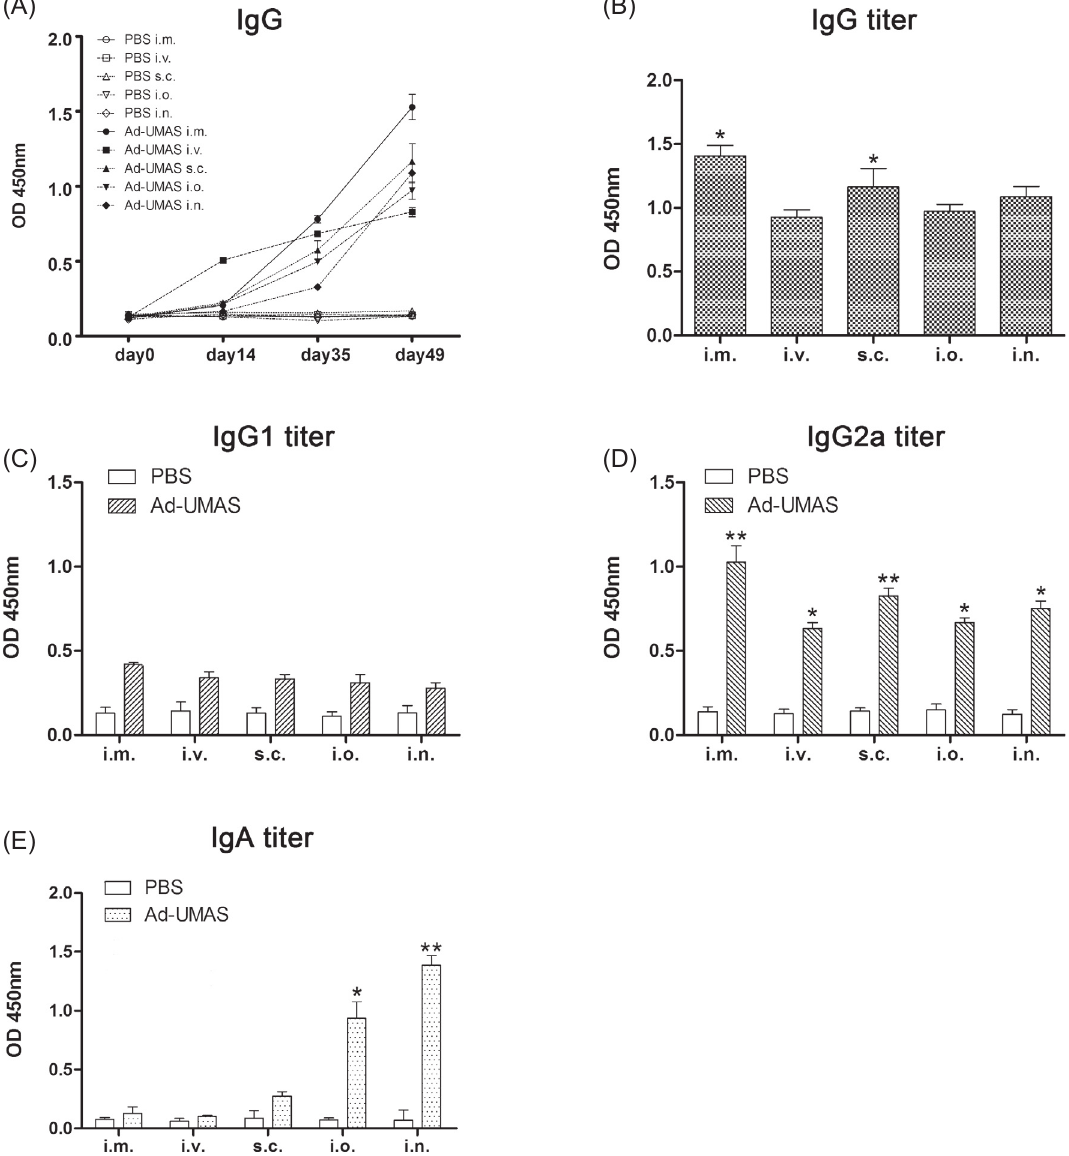
Figure 2. Systemic humoral immune response and local mucosal immune response induced by Ad-UMAS via different immunization routes. (A) IgG antibodies detected in murine serum collected on days 0, 14, 35, and 49. (B) IgG, (C) IgG1, (D) IgG2a, and (E) IgA titers were detected using sera from 4 weeks after the last vaccination. The results are expressed as the mean of the OD450 ± SD and are representative of three experiments. Asterisks mark the significant difference: * p < 0.05; ** p < 0.01. Each bar represents the mean OD (± SD , n =